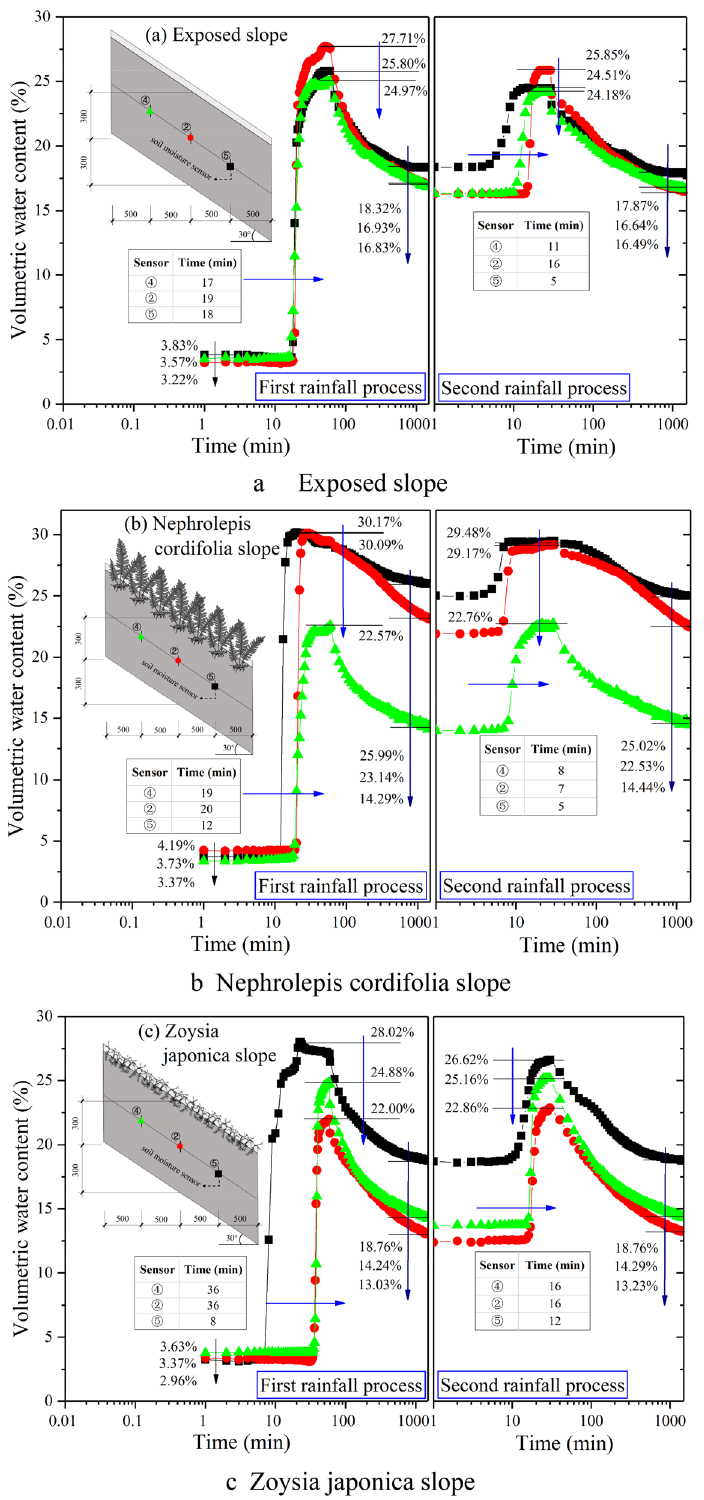
Figure 6. Variation in the soil moisture content at the depths of sensors ② , ④ and ⑤